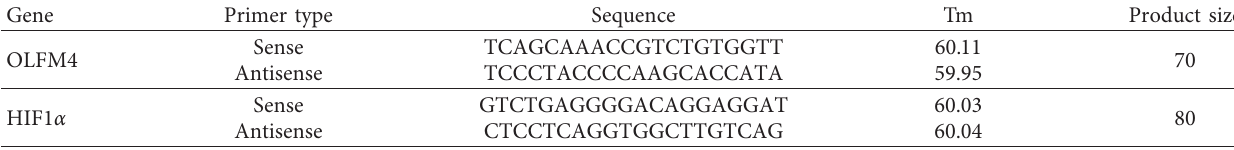
Table 1: Primers of OLFM4 and HIF1 α .